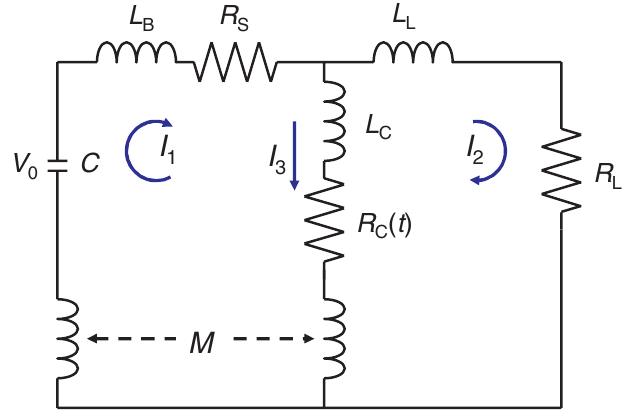
FIG. 3. (Color) Equivalent circuit model of the 1-MA LTD cavity including variable resistance R C ð t Þ core loss model and mutual inductance M between the core and brick circuit